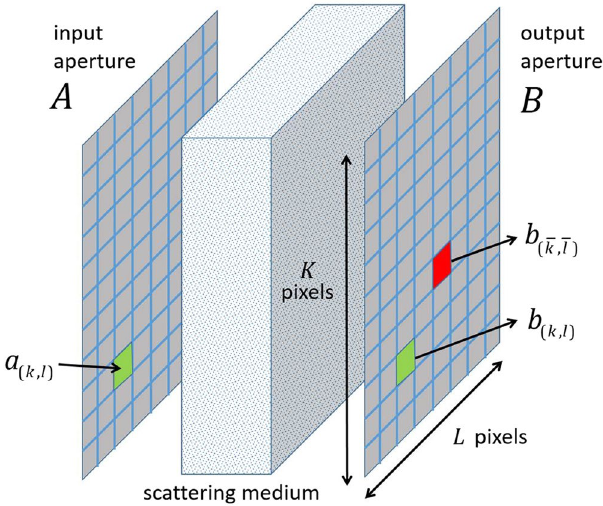
Figure 1. Algorithm conceptual setup: the scattering medium is sandwiched between two rectangular apertures ( A and B ). The corresponding optical setup is shown in Fig. 2.